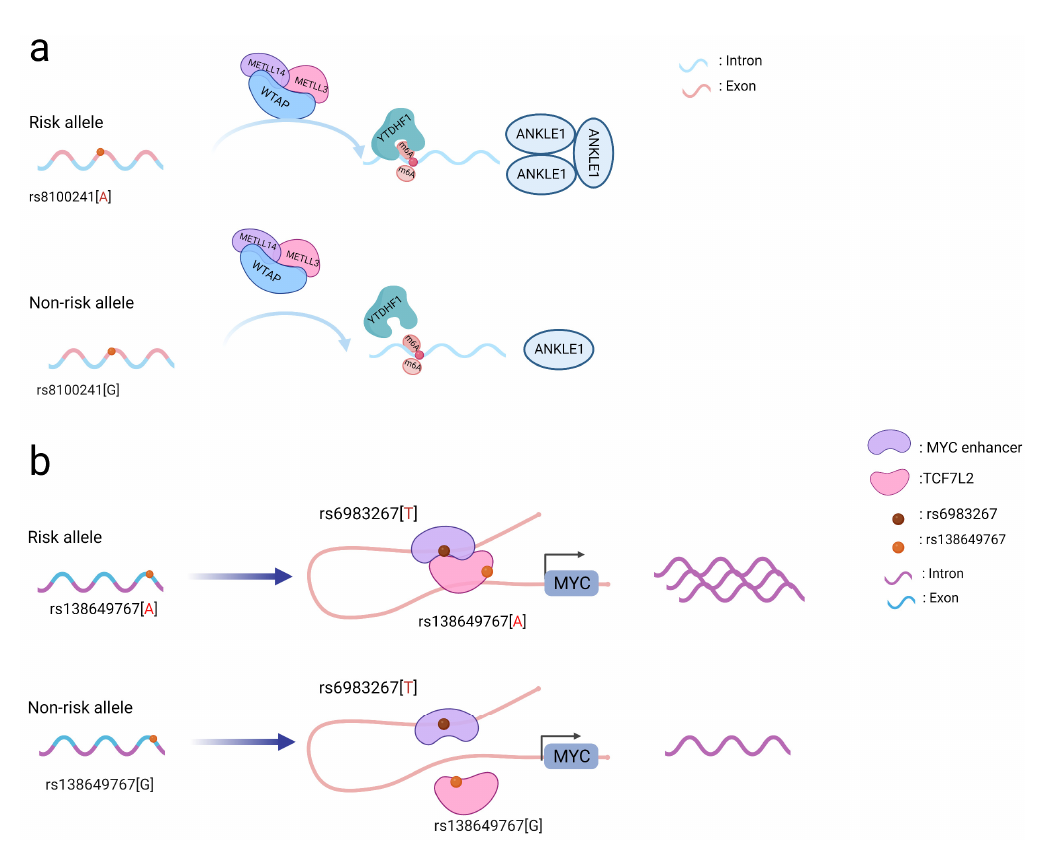
Figure 1. Schematic diagram of the action mechanism employed by coding SNPs. ( a ) The A allele of the rs8100241 variant, which is found in the ANKLE1 second exon region, has been linked to a lower risk of CRC by increasing ANKLE1 mRNA m6A levels and thus facilitating ANKLE1 protein expression, thereby potentially functioning as a negative regulator to hinder cell growth by maintaining genomic stability. ( b ) Interaction between the TCF7L2 missense variant rs138649767 and a regulatory variant rs6983267 in the MYC enhancer and promoter on the expression of